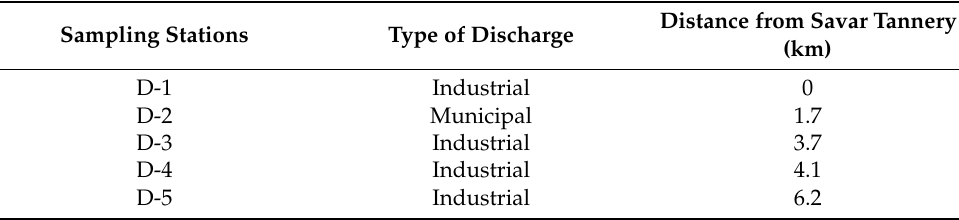
Table 1. Identification of sampling stations and distance from D-1 in Dhaleshwari River.